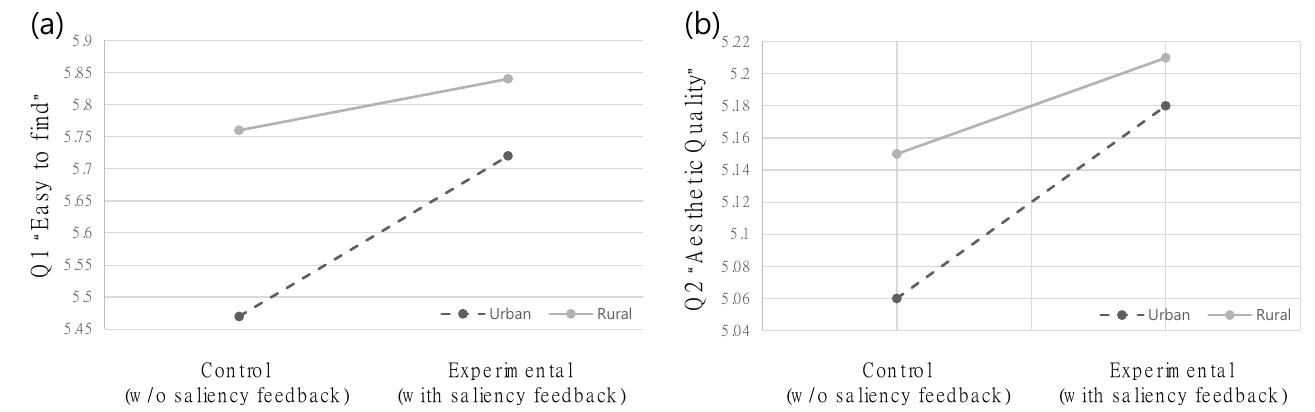
Figure 13. Interaction effect between the provision of saliency feedback during design and the environment on ( a ) Q1 (“easy to find”) and ( b ) Q2 (“aesthetic quality”). The tool improved the conspicuity and aesthetics—particularly in urban areas. (Control: sign designs that were produced without prediction function, experimental: sign designs that were produced with saliency prediction function.)